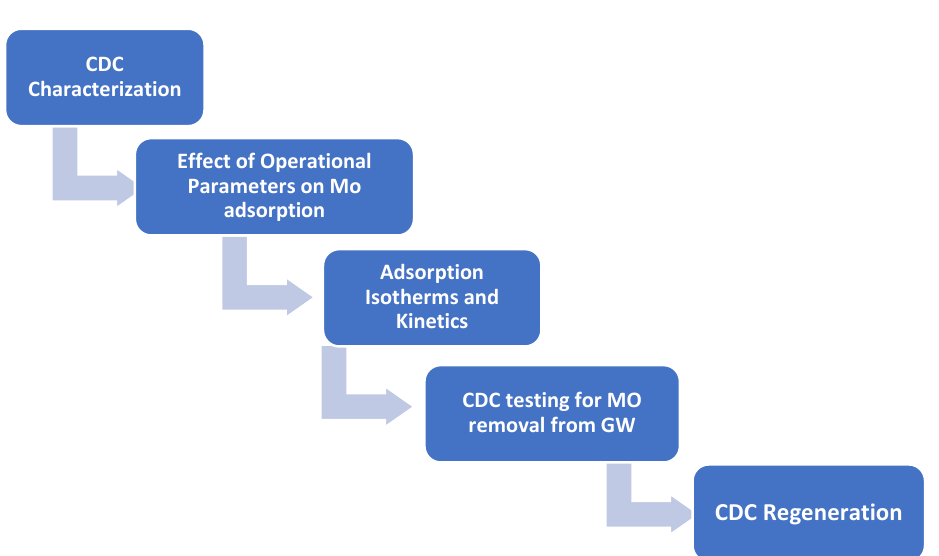
Figure 1. Schematic of the experimental work performed in this study.